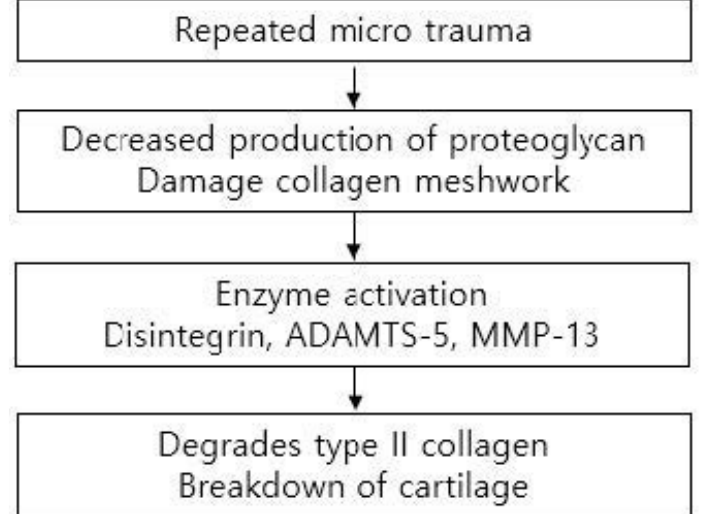
Figure 4. Mechanism leading to the breakdown of cartilage.